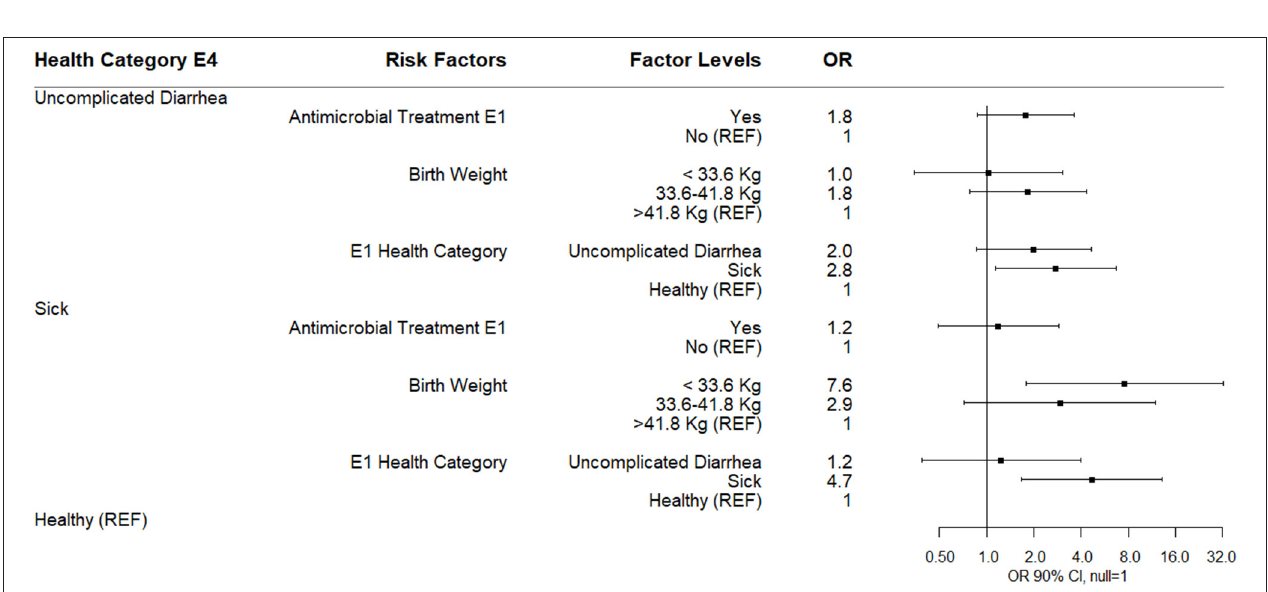
FIGURE 6 | Results of multinomial logistic regression modeling risk factors for health category at sampling day E1. Odds ratios and 90% confidence intervals are shown. E0 health categories were defined as: sick (diarrhea with not finishing milk meal and/or depressed attitude), uncomplicated diarrhea (diarrhea with no additional clinical signs), and healthy.